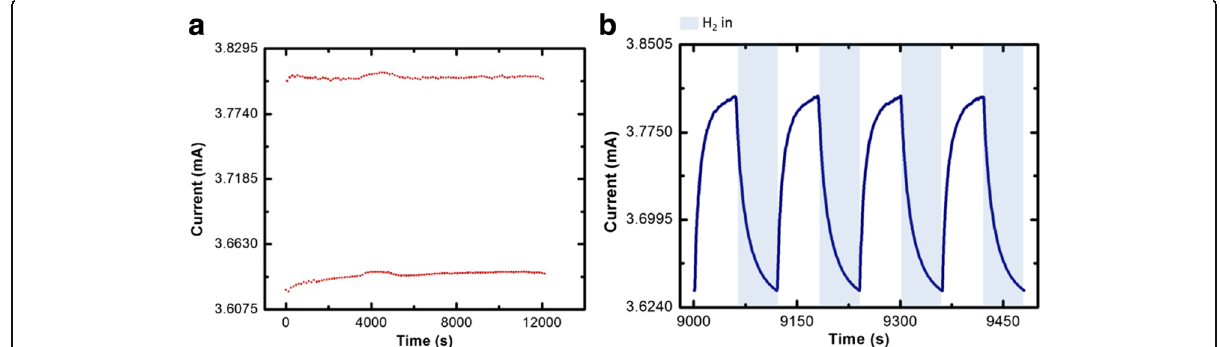
Fig. 3 Hydrogen gas sensing behaviour for UV activated sensor working at 100 ° C. a Maximum and minimum point for 100 cycles. b Response of CuO NWs sensors toward hydrogen gas